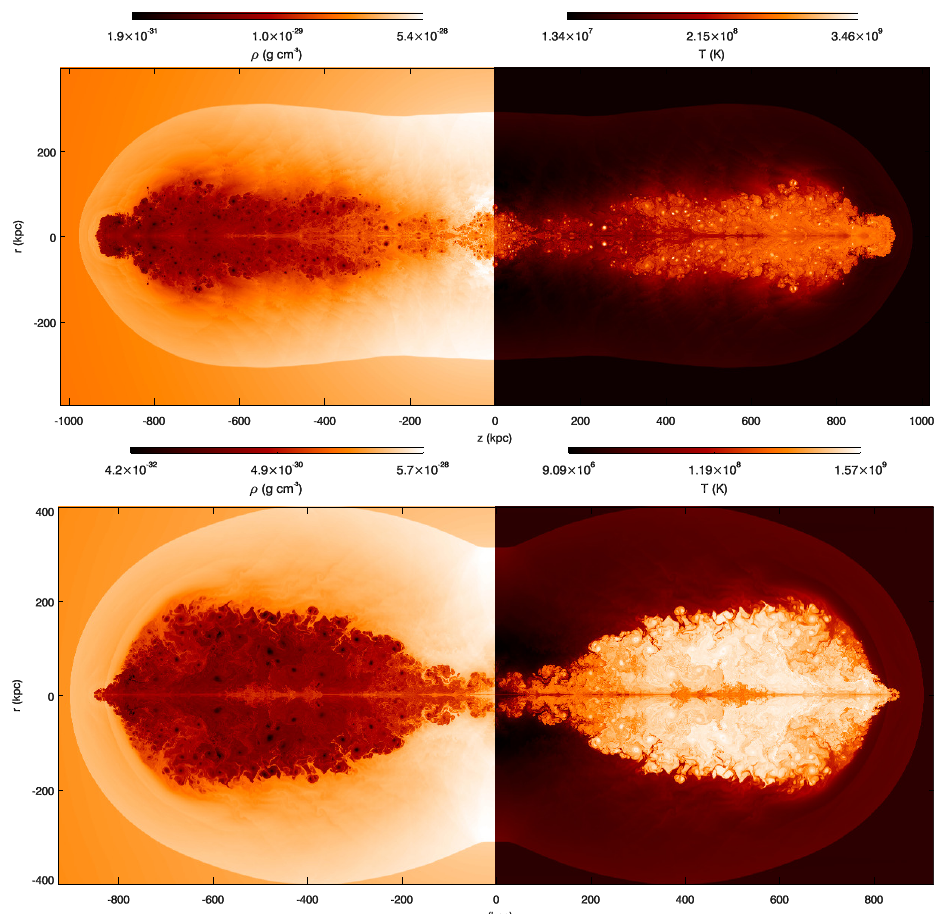
Figure 8. Density ( left ); and temperature ( right ) of two simulations of a powerful jet ( L j = 10 46 erg/s) propagating through the ICM after jet’s switch-off. Top panel : non-relativistic, electron-proton jet; bottom panel : relativistic leptonic jet. In both cases, the jet density at injection (1 kpc from the cental engine) is 8.3 × 10 − 29 g cm − 3 . The jet flow speeds at injection are 0.3 c for the non-relativistic jet, and 0.984 c (Lorentz factor ≈ 5.61) for the relativistic one. To compensate the smaller inertia, the jet radius at injection of the non-relativistic jet has the unrealistic value of 3 kpc (0.1 kpc in the relativistic jet). (Adapted from Figures 7 and 8 of